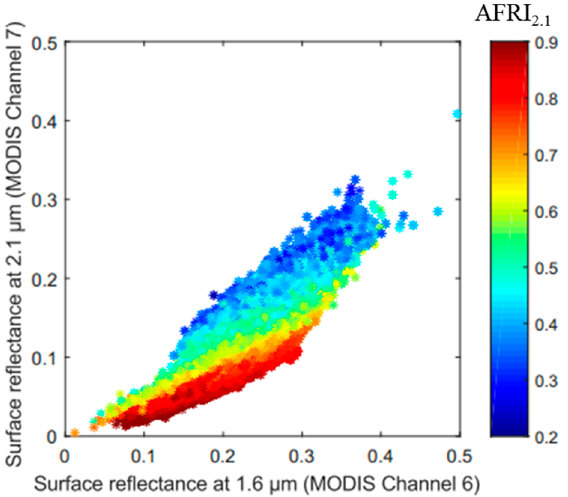
Figure 2. The MODIS surface reflectances at 2.1 µm as a function of surface reflectance at 1.6 µm and AFRI 2.1 . The color bar shows the values of AFRI 2.1 for each point.